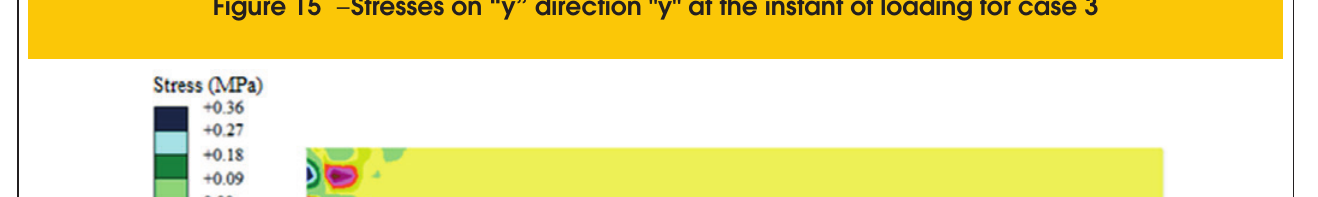
Figure 15 – Stresses on “y” direction "y" at the instant of loading for case 3